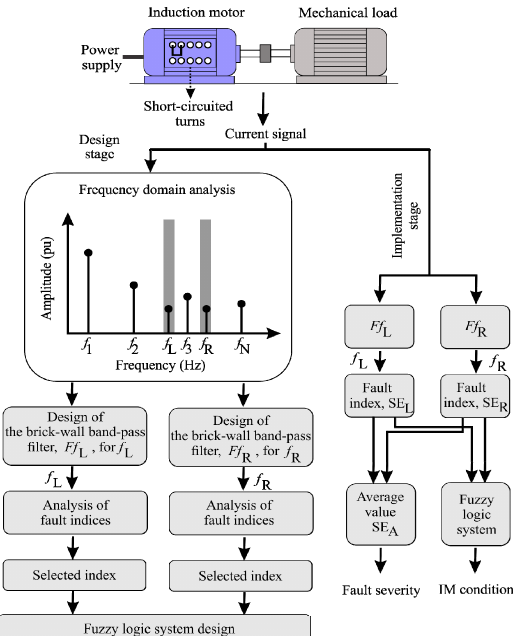
Figure 2. Proposed methodology.